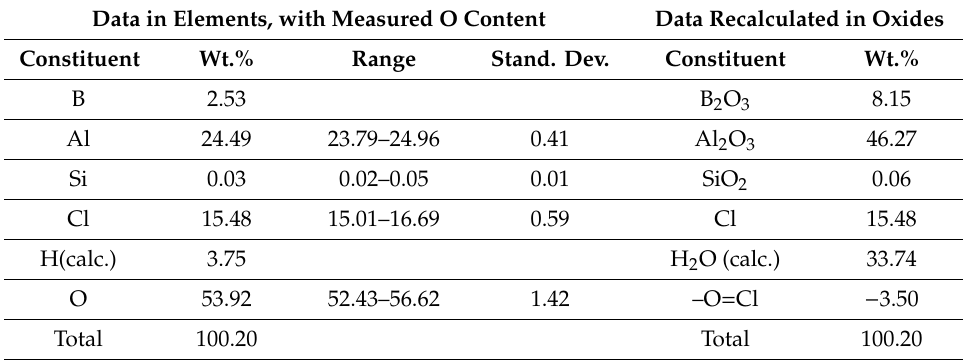
Table 1. Chemical composition (in wt.%) of krasnoshteinite in elements and in oxides (Al, Si, Cl, and O: average data for 7 spot electron-microprobe